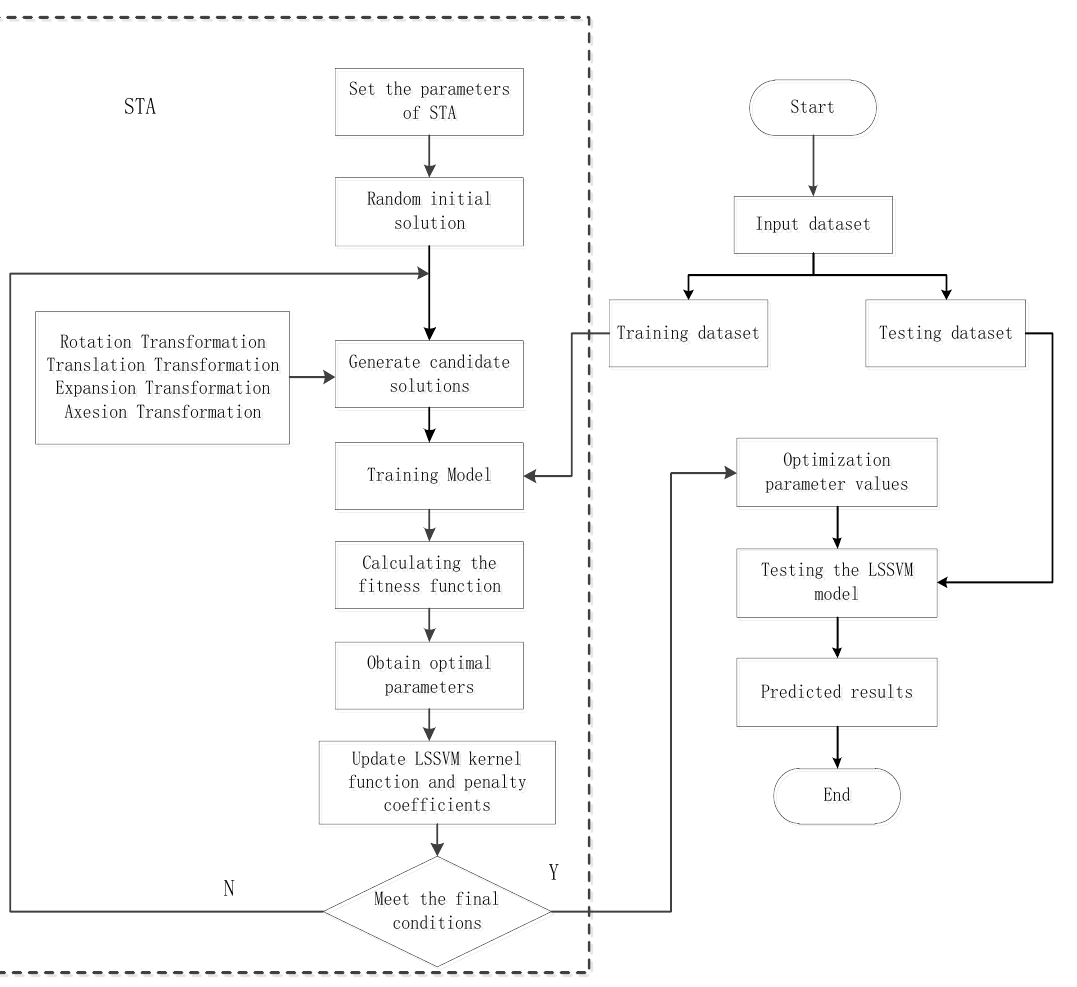
Figure 3. The schematic of STA-LSSVM algorithm flow.